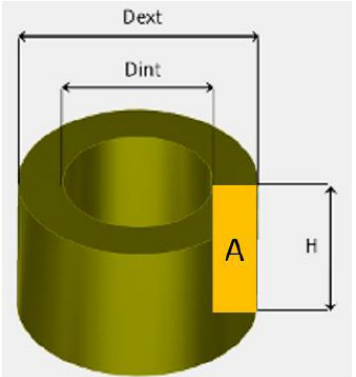
Fig. 13. Eddy current coil